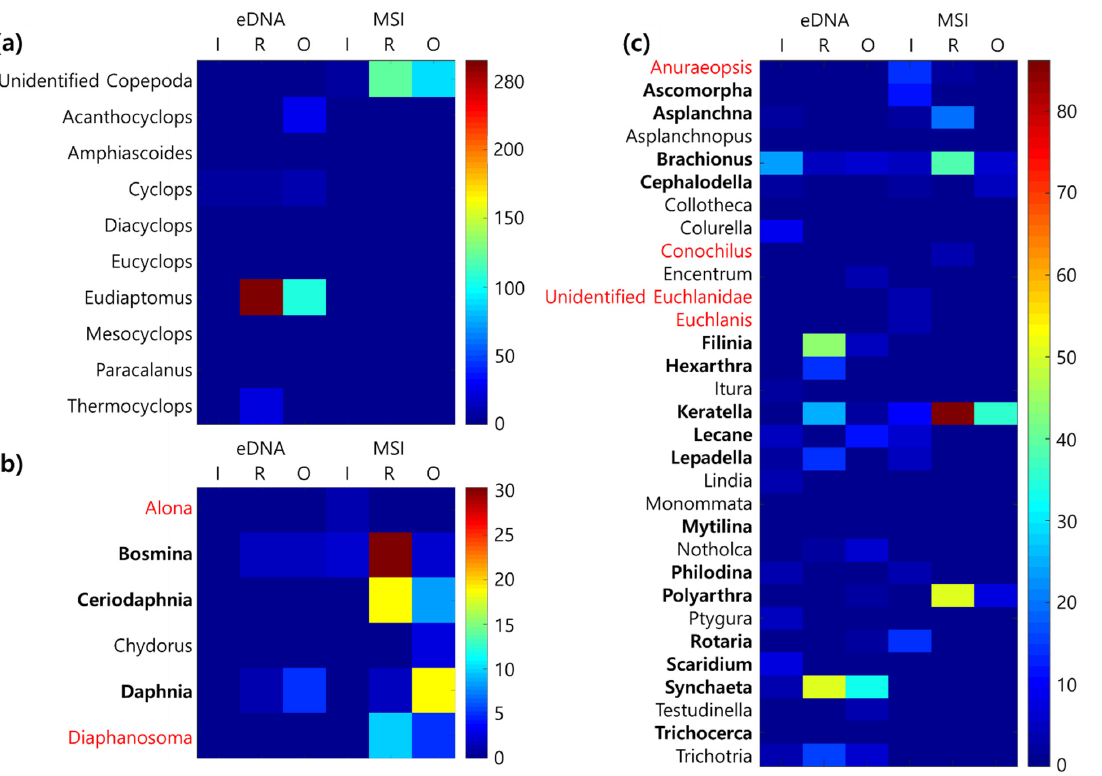
Figure A1. Detected genus list of zooplankton (( a ) Copepoda, ( b ) Cladocera, ( c ) Rotifera) and frequencies of the genus in each taxon. Colors indicate the summation of each taxon frequency in each sampling site during the sampling period. Bold characters indicate the genus detected in both sampling methods (MSI and eDNA metabarcoding), and red characters indicate genera that do not have 18S rRNA genetic information in the NCBI database.